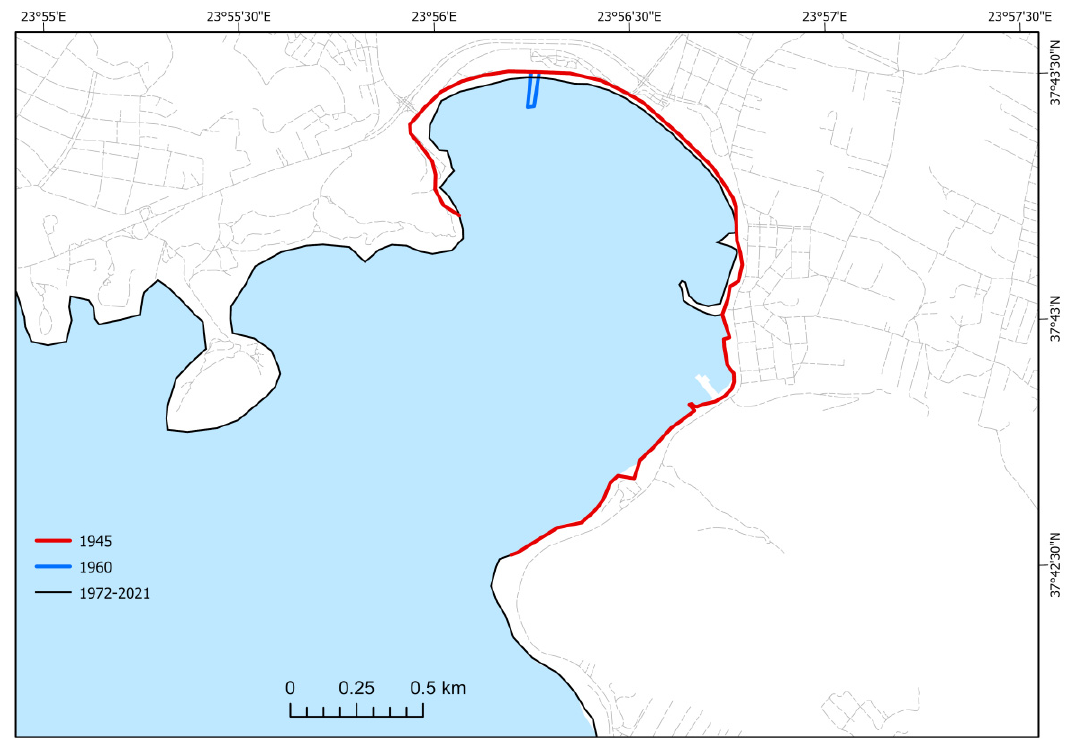
Figure 10. The coastline changes from 1945 to 2021 in Anavyssos